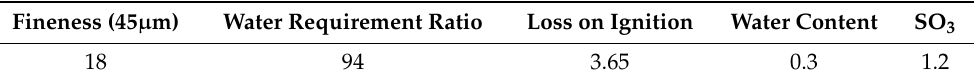
Table 4. Physical properties of fly ash